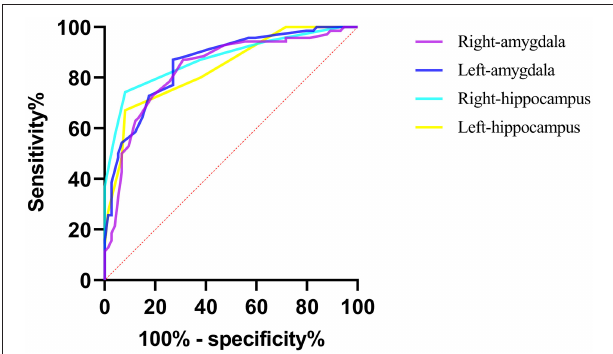
FIGURE 4 | ROC curves showed the ability of the bilateral hippocampus and amygdala APTw values to diagnose aMCI